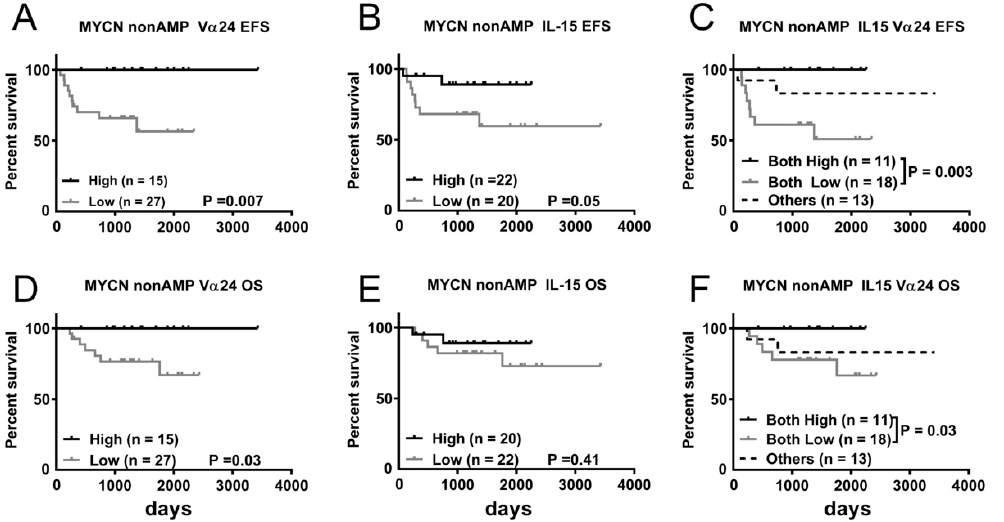
Figure 5. Survival benefit of greater abundance of V α 24 and IL-15 expression in tumor tissues of MYCN-non-amplified NBL patients. Kaplan–Meier curves showing EFS ( A – C ) and OS ( D – F ) of 53 MYCN-non-amplified NBL patients according to IL-15 ( A , D ), V α 24 ( B , E ), and IL-15 + V α 24 combined ( C , F ) expression. Log-rank test was applied for statistical compar-